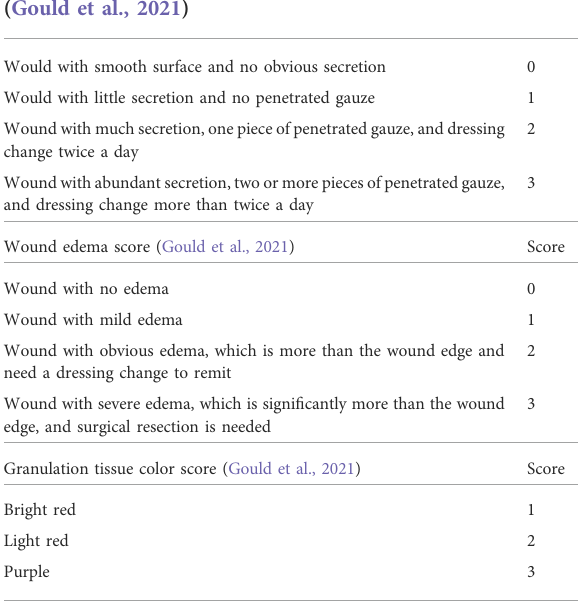
TABLE 2 Scale for assessing wound